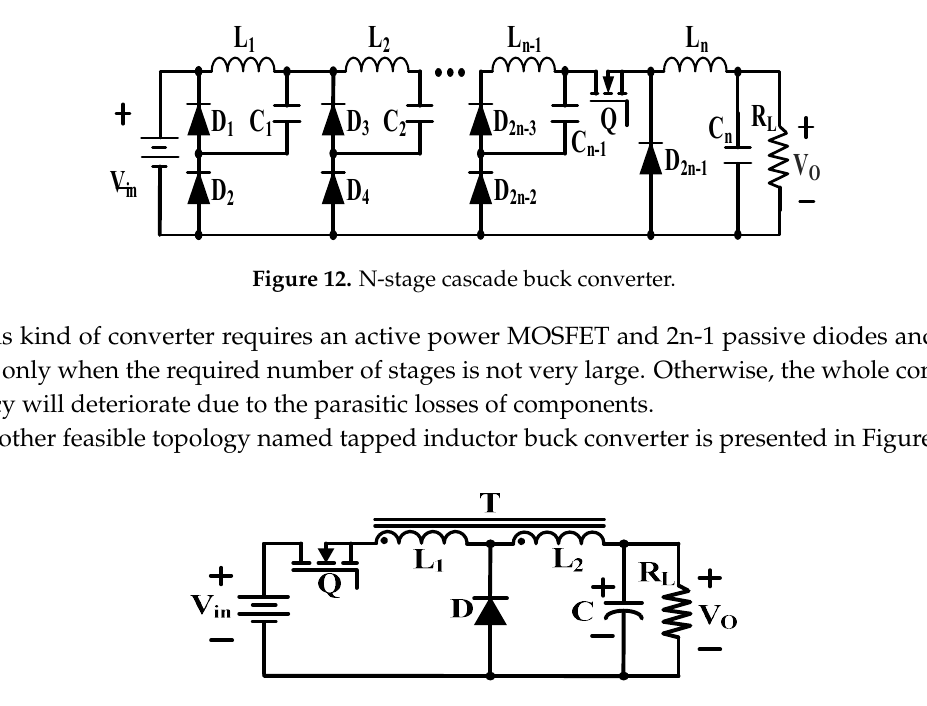
Figure 13. Tapped inductor buck converter.